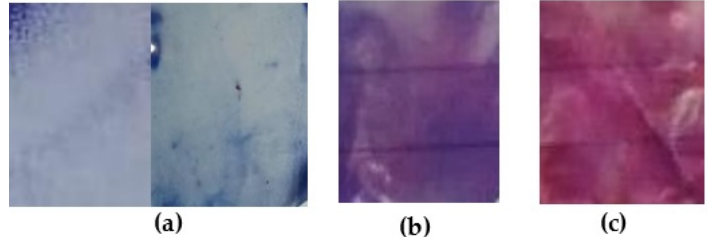
Figure 4. Films of cellulose acetate-based incorporated with polydiacetylene (42.63 mg) and triethyl citrate (17.73%) at pH 4.0 after 18 min of UV-light exposure: ( a ) at room temperature; ( b ) at 28.0 °C and ( c ) at 71.1 °C .